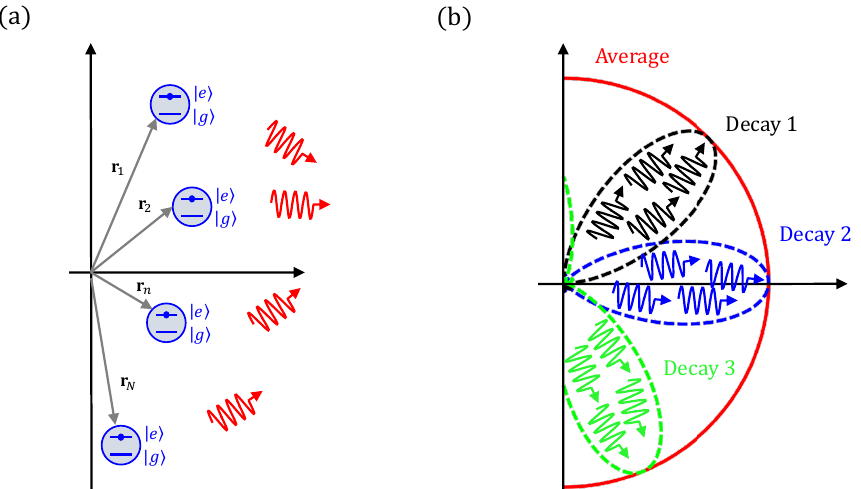
Figure 1. ( a ) Sketch of the geometry. An ensemble of N quantum emitters are located at positions r 1 , . . . , r N . They are modelled as two-level systems {| e (cid:105) , | g (cid:105)} . All of these emitters are initially excited | ψ (cid:105) = | e 1 · · · e N (cid:105) and decay by emitting photons. The photon emission occurs in correlated directions that depend on the geometry of the array. ( b ) Conceptual sketch of directional photon bunching. The average number of photons measured in a given direction has an isotropic emission pattern (solid red line), but each array decay process exhibits bunching of the photons along specific directions (dashed